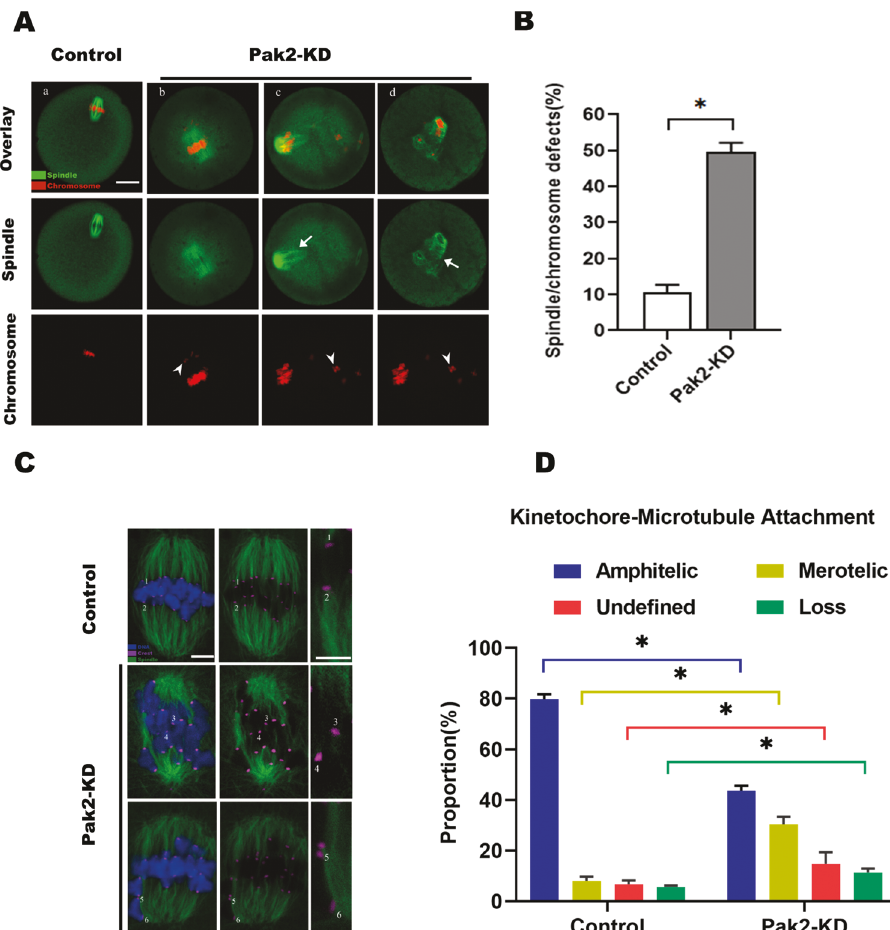
Fig. 3 PAK2 is essential for meiotic apparatus organization. A Control and Pak2 -KD oocytes were stained with α ‐ tubulin antibody to visualize the spindle (green) and counterstained with PI to observe chromosomes (red). (a) Control oocytes show the characteristic barrel- shaped spindle and well-aligned chromosomes. (b – d) Three examples illustrating the disorganized spindles (arrows) and misaligned chromosomes (arrowheads) that were frequently observed in Pak2 -KD oocytes (scale bar, 20 μ m). B Quanti fi cation of control and Pak2 -KD oocytes with spindle/chromosome defects (10.7 ± 1.70%, n = 116; 49.7 ± 2.05%, n = 102, respectively). C Control and Pak2 -KD metaphase oocytes were labeled with CREST antibody for kinetochores (purple), anti-tubulin antibody for microtubules (green), and Hoechst 33342 for chromosomes (blue) (representative confocal images are shown). Chromosomes labeled 1 and 2 represent examples of amphitelic attachment (79.7 ± 1.70%, n = 42, control; 43.7 ± 1.70%, n = 47, Pak2 -KD), chromosomes 3 and 4 represent lost attachment (5.7 ± 0.47%, n = 42, control; 11.3 ± 1.25%, n = 47, Pak2 -KD), chromosome 5 represents merotelic attachment (8.0 ± 1.41%, n = 42, control; 30.3 ± 2.49%, n = 47, Pak2 -KD), and chromosome 6 represents unde fi ned attachment (8.0 ± 1.41%, n = 42, control; 30.3 ± 2.49%, n = 47, Pak2 -KD) (scale bar, 5 μ m). D Quantitative analysis of K-MT attachments in control and Pak2 -KD oocytes (kinetochores in regions where fi bers were not easily visualized were not included in the analysis). Graph shows the mean percentage±SD of the results obtained from three independent experiments. *Signi fi cantly different ( p <